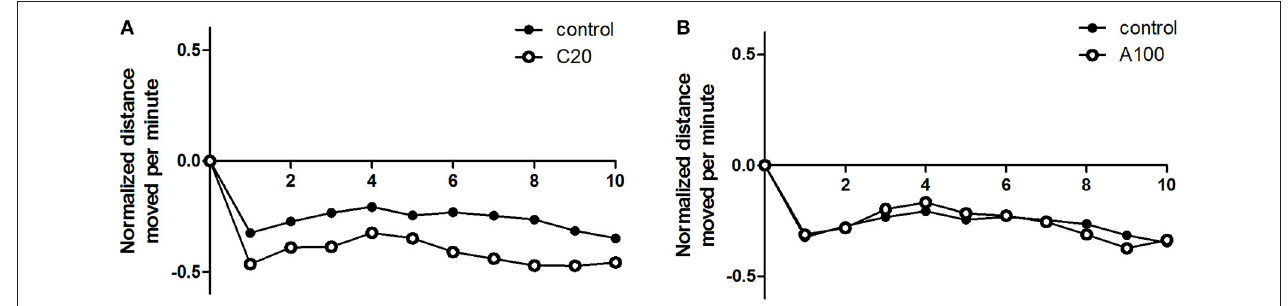
FIGURE 6 | Effects of chronic or acute exposure to VPA on behavioral responses to light change in zebrafish at 1 month of age. Distance moved per minute in the 10-min dark phase was normalized against the average distance moved in the previous 10-min light phase. The control group (filled circles) was plotted with chronic exposure to 20 µ M VPA (open circles) and acute exposure to 100 µ M VPA (open circles) in (A,B), respectively. The data are presented as the mean ± SEM, n = 32 animals per group.